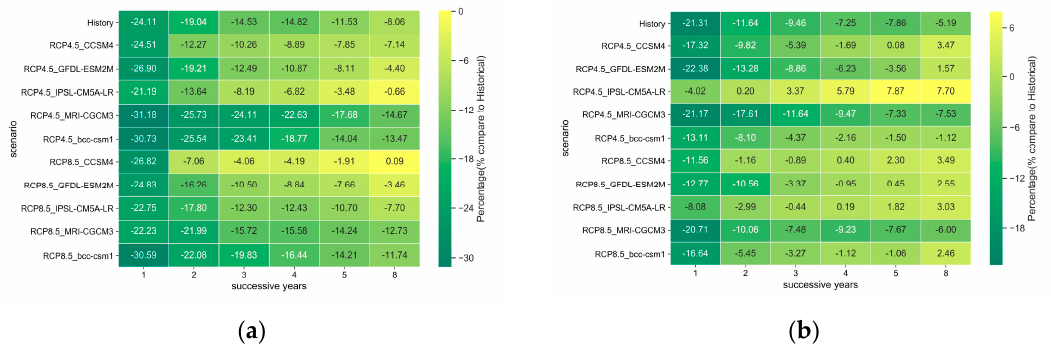
Figure 10. Multi-year drought hydropower generation compared to historical yearly average (the x axis is consecutive years). ( a ) LCCHS, and ( b ) JSCHS.